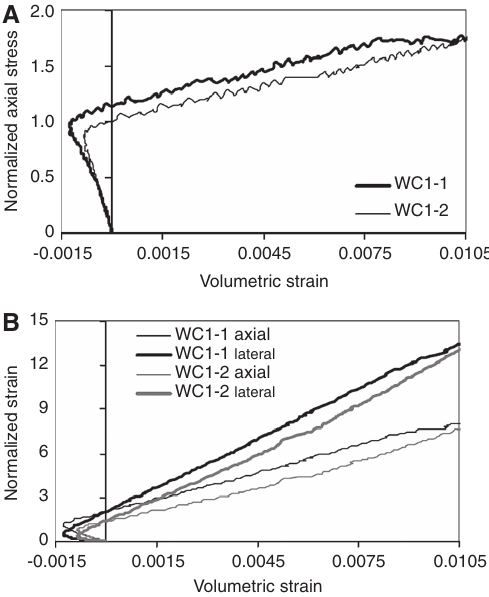
Figure 3 Stress-strain curves for WG3 specimens.